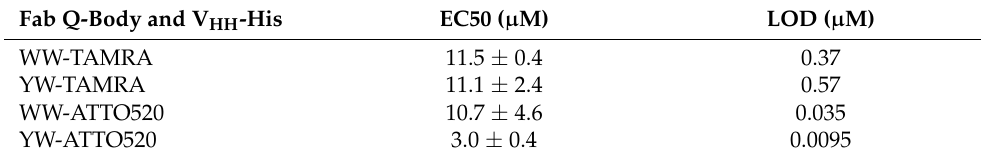
Next, we used the Q-bodies to determine the amount of V HH -His protein secreted by Brevibacillus in 50% M9 culture medium at different time points. As the culture time passes,